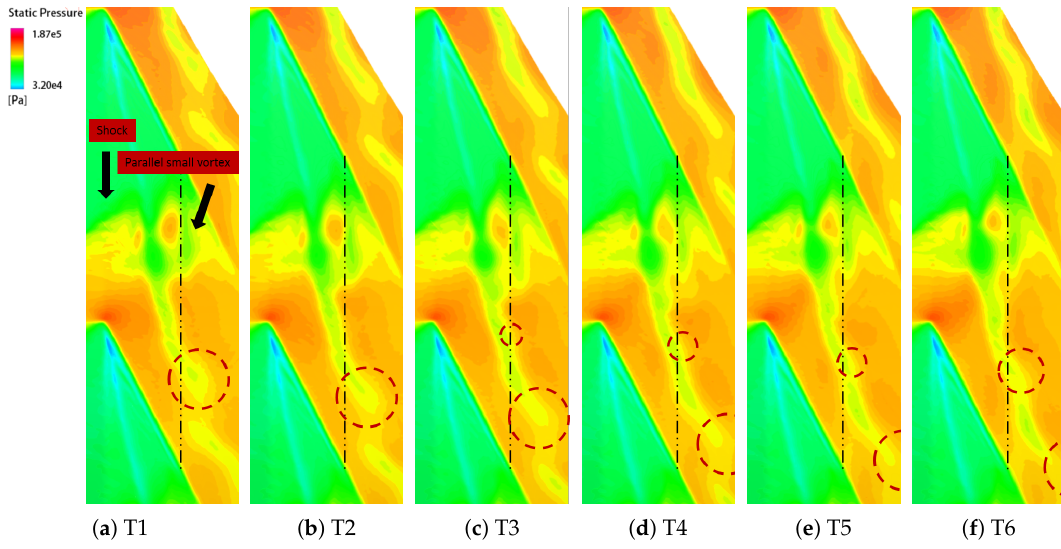
Figure 15. Casing Pressure Contour in One Period at